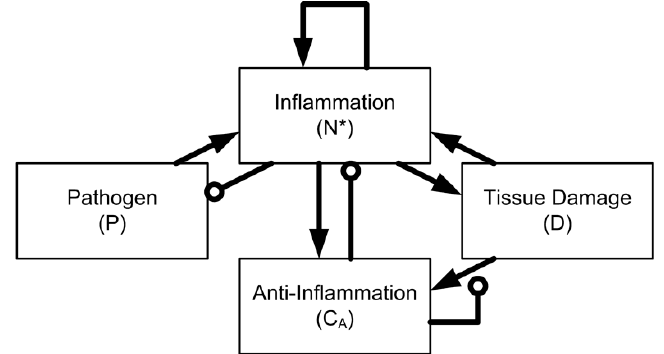
Figure 1. Network structure of the four-variable model. The model is defined by interaction between a pathogen ( P ), activated phagocytes ( N* ), tissue damage ( D ), and anti-inflammatory mediators ( C A ).